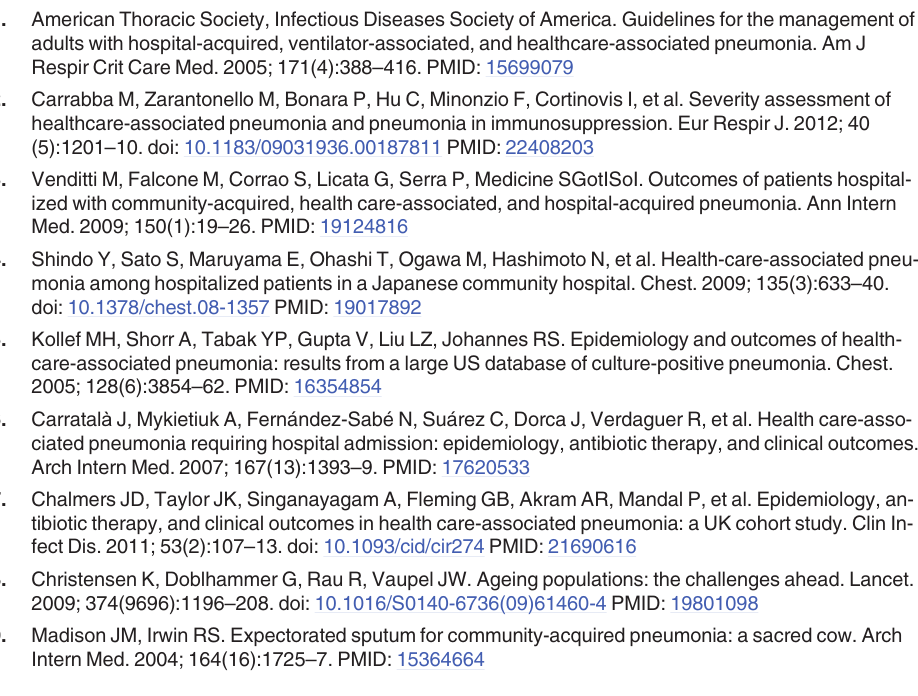
S2 Table. Results of the molecular method and antibiotics efficacy in patients with positive cultivation of Pseudomonas aeruginosa . S3 Table. Results of the molecular method and antibiotics efficacy in patients with positive cultivation of Klebsiella pneumonia . S1 Fig. Percentage of detected phylotypes in the “ monobacteria-dominant ” and “ mixed bacteria ” groups. A) Percentage of phylotypes in each sample among the 30 patients in the “ monobacteria-dominant group ” ; B) Percentage of phylotypes in each sample among the 50 patients in the “ mixed bacteria group. ” Phylotypes present at a rate of less than 5% in each li- brary were classified as “ others.